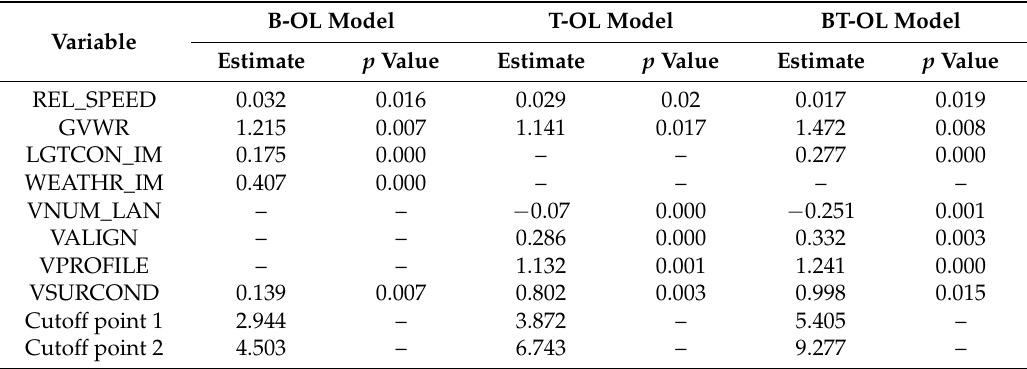
Table 6. Parameter estimation based on the OL